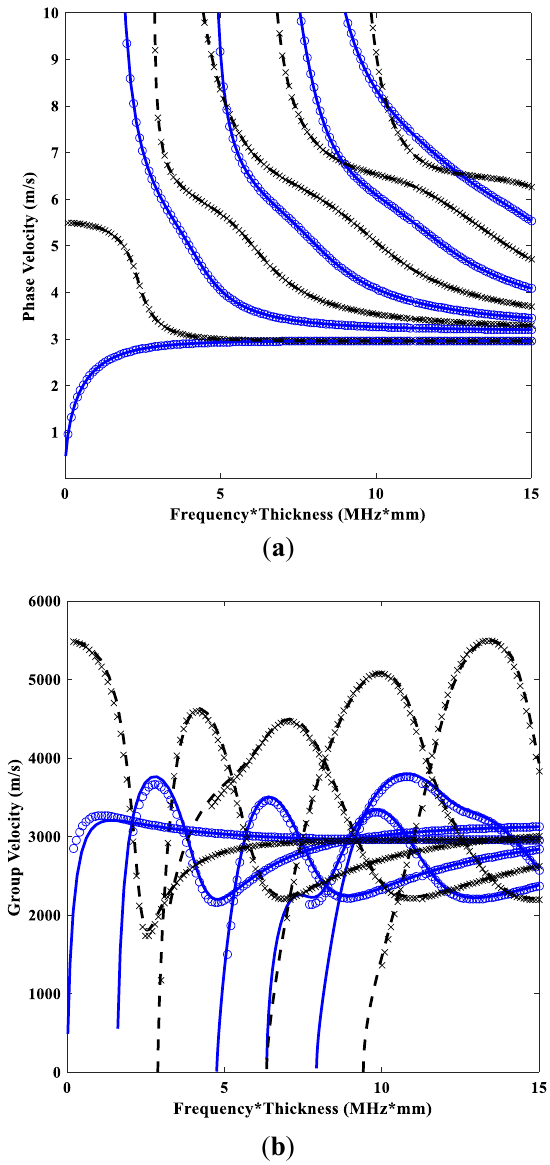
Figure 2 Dispersion curves for Lamb wave in an Al6061-T6 thin plate: ( a ) phase velocity and ( b ) group